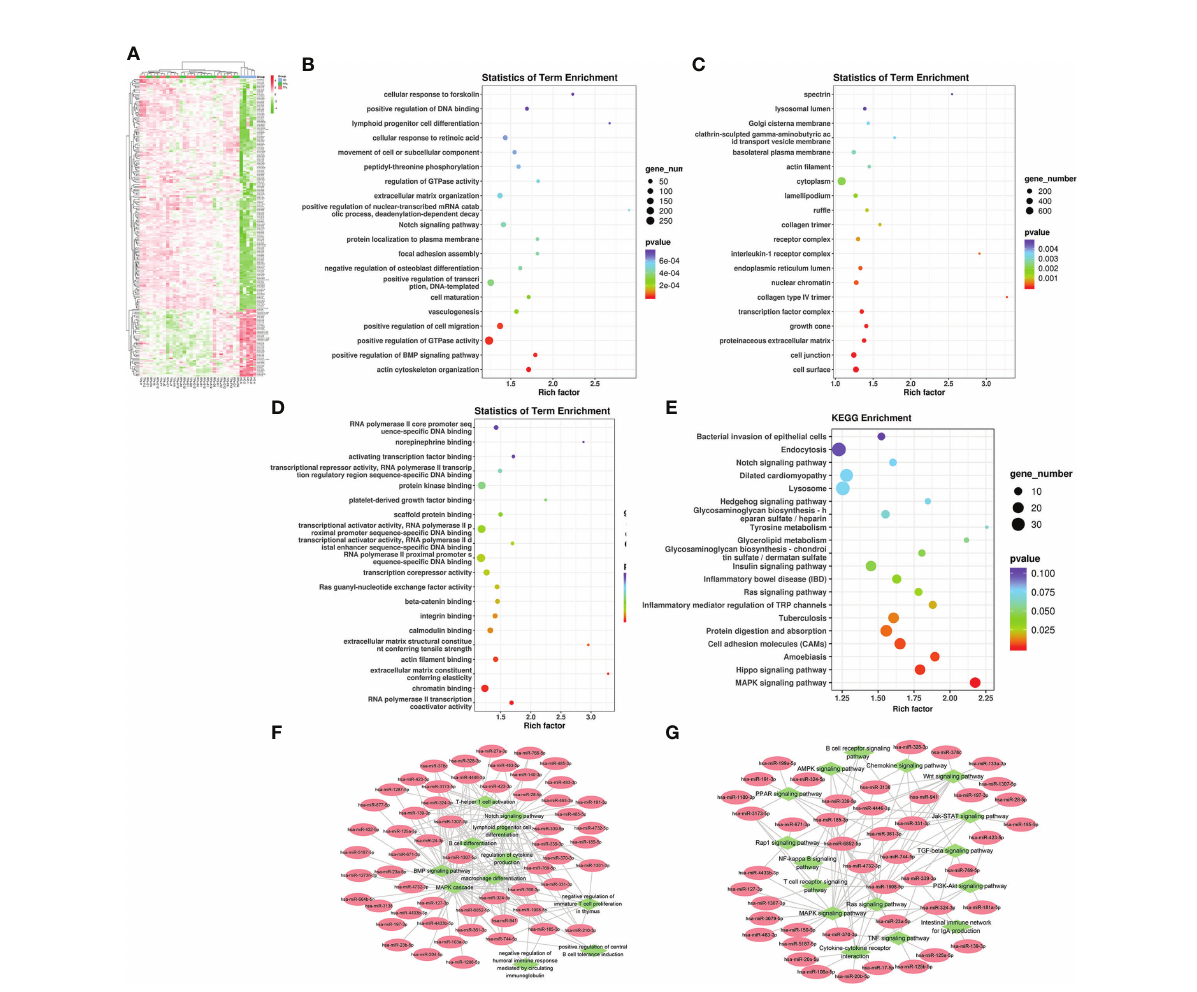
FIGURE 3 The analysis of differential HIV-speci fi c miRNAs expression pro fi le and their function. (A) The Cluster heatmap of the 208 differential exosomal miRNAs between HIV acute infected patients and HCs. (B-D) The GO terms interpretation for the functions of these 208 differential miRNAs. (E) The KEGG terms interpretation for the functions of these 208 differential miRNAs. (F) The miRNA target interaction regulatory network form GO terms. (G) The miRNA target interaction regulatory network form KEGG